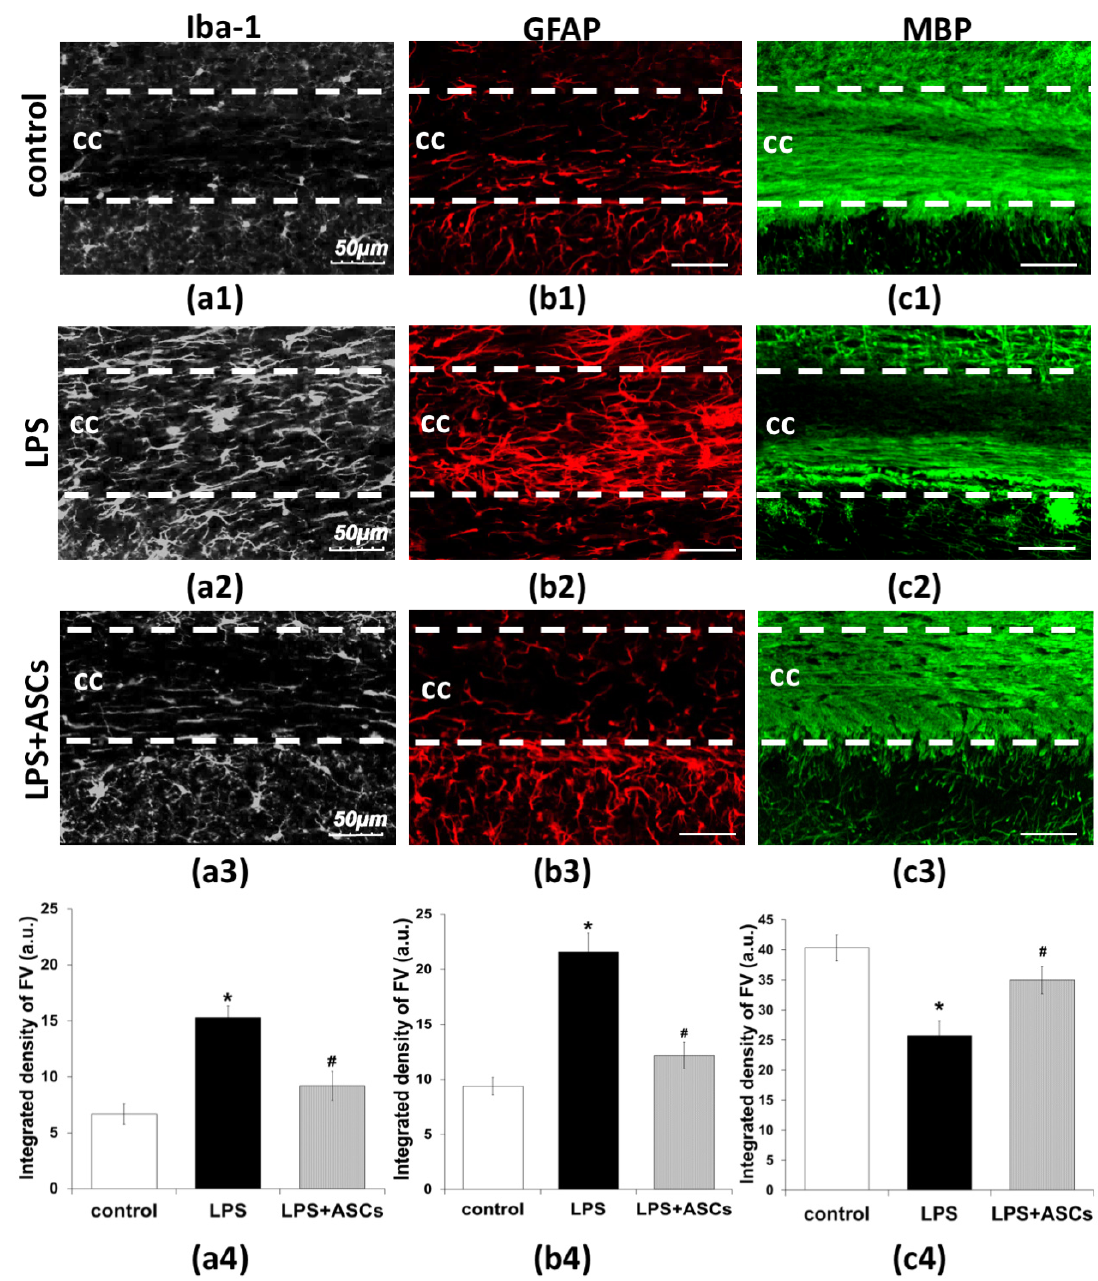
Figure 2. Confocal micrographs of coronal sections of the mice brain stained for Iba-1 (white), GFAP (red) and MBP (green) at day 30 after LPS injection: ( a1 , b1 , c1 ) control animals (n = 80); ( a2 , b2 , c2 ) LPS-treated animals (n = 80); ( a3 , b3 , c3 ) LPS-treated animals and ASCs transplantation (n = 80) (30 day after transplantation). cc—corpus callosum, ASCs—adipose-derived stem cells, LPS—lipopolysaccharide. Scale bar = 50 μ m. ( a4 , b4 , c4 ) histogram of integrated fluorescence density. a.u.—arbitrary units. Note: *—statistically significant di ff erence compared with control ( p < 0.05), #—statistically significant di ff erence compared with LPS-treated animals ( p < 0.05). n = the number of analyzed